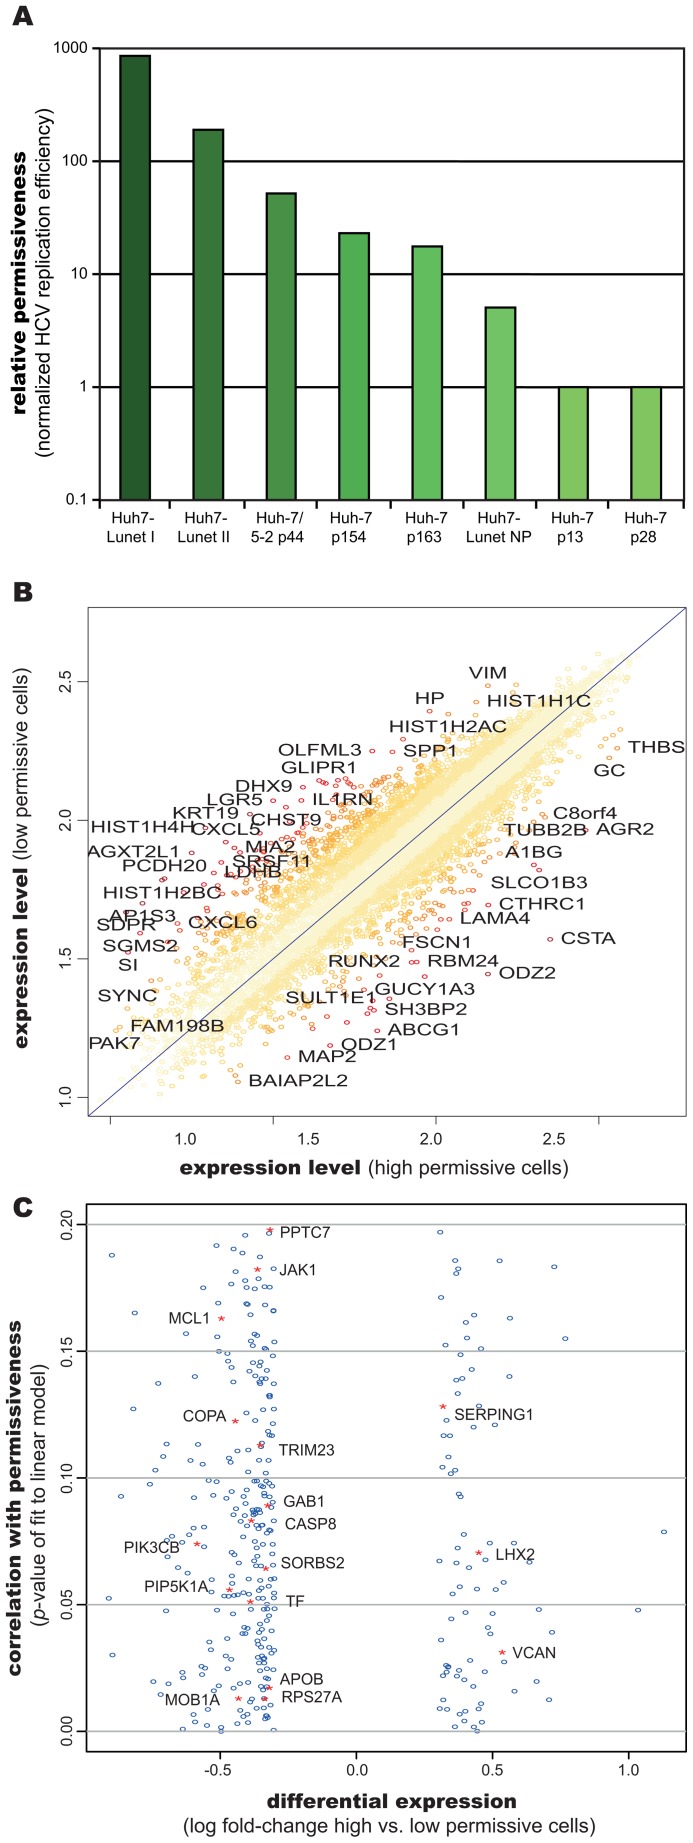
Gene expression profiling of differently permissive Huh-7 cells.(A) Relative permissiveness for HCV replication of eight different Huh7 derived cell lines. Permissiveness was normalized to Huh-7 p28 cells. (B) Scatterplot of host gene expression in high permissive Huh7-Lunet versus low permissive Huh-7 lp cells. Off-diagonal elements are differentially expressed and are potential candidates underlying the difference in replication efficiency. Colors encode the distance from the diagonal. A selection of strongly differentially expressed genes is labeled with gene symbols. (C) Eight different cell lines with different replication permissiveness (see panel A) were used, and replication efficiency was correlated with host gene expression. A linear model was fitted to predict replication permissiveness from gene expression data, and goodness of fit assessed using ANOVA. Shown are resulting p-values, plotted over the log- fold-change of expression between Huh7-Lunet and Huh-7 lp cells. Shown are genes with p-values<0.2 and a log-fold-change of more than 0.3 or less than −0.3. Seventeen genes that were previously shown to be functionally linked to HCV replication or to directly interact with viral proteins are highlighted in red and labeled.